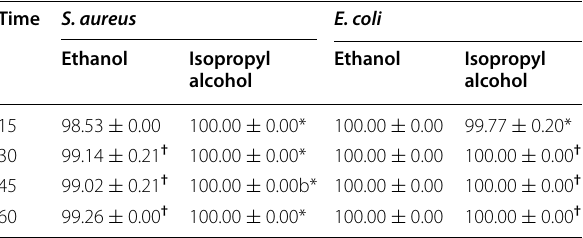
Values represent means SD. Values with * indicate a significant difference ± ( P < 0.05) from ethanol for the same time/organism. Values with superscript † indicate a significant difference ( P < 0.05) from 15 s for the same alcohol/ organism. N